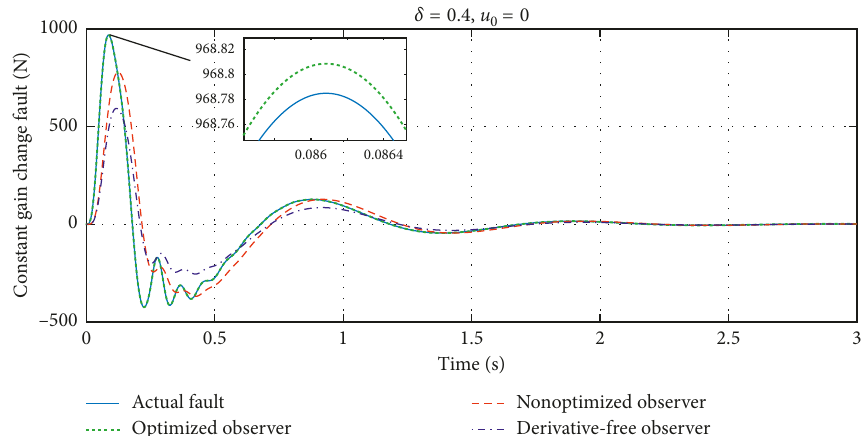
Figure 5: Tracking effects of the constant gain change fault ( bump road ).